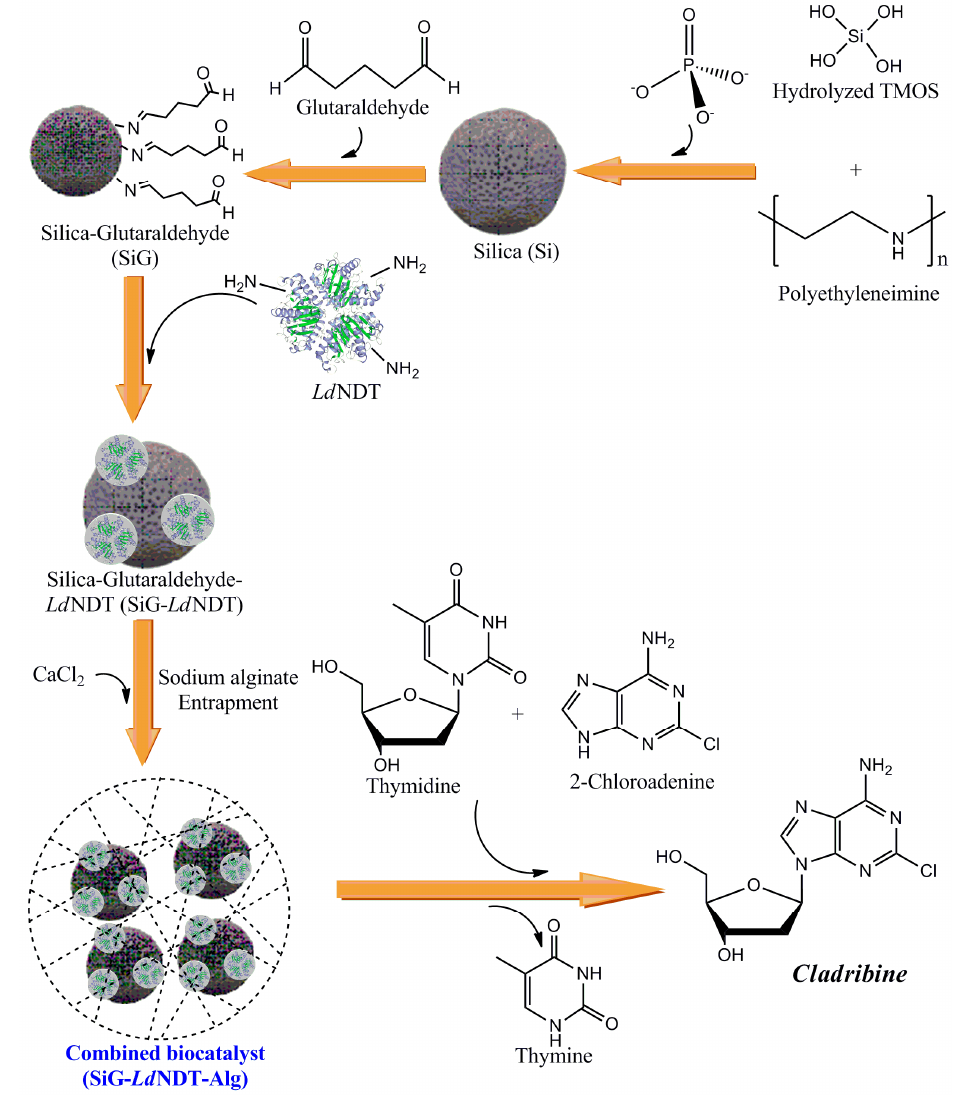
Figure 1. Schematic representation of the combined immobilization procedure, carried out in this work to obtain cladribine, through the development of a highly stabilized biocatalyst. TMOS: tetramethylorthosilicate, PEI: Polyethyleneimine and Ld NDT: Recombinant NDT from Lactobacillus delbrueckii.